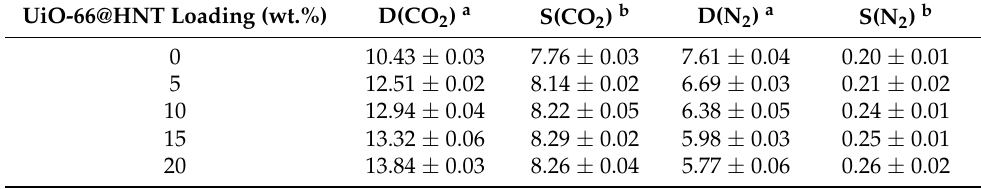
Table 2. Gas diffusivity coefficients and solubility coefficients of UiO-66@HNT/Pebax membranes. UiO-66@HNT Loading (wt.%)